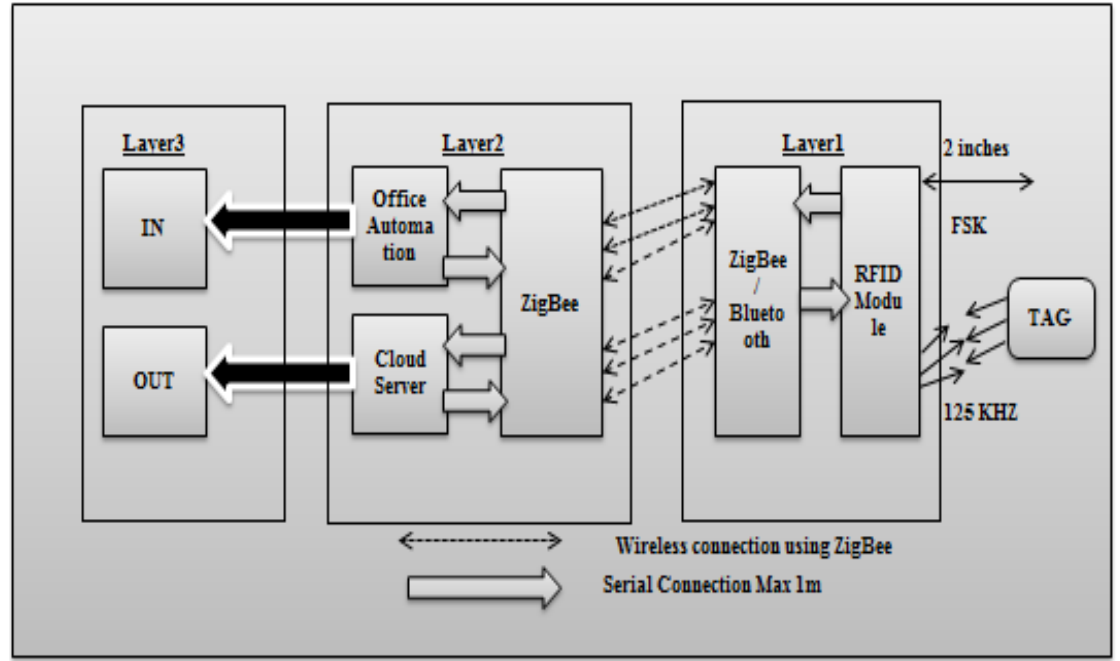
Fig 1.3. proposed system block